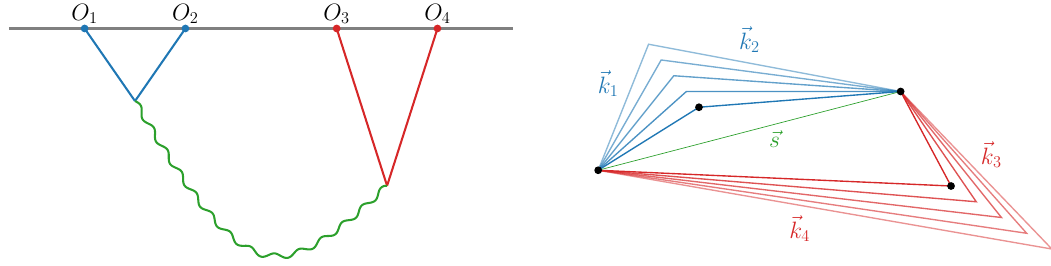
Figure 1: Correlations measured at the end of inflation are created during a period of quasi-de Sitter expansion in the early universe. These correlations capture infor- mation about the production and decay of massive particles during inflation ( left ). For weakly interacting particles, the boundary correlators are constrained by the isometries of the spacetime, which act as conformal transformations on the boundary. These constraints take the form of “conformal Ward identities," which are differential equations that dictate how the strength of the boundary correlations changes when the external momenta are varied ( right ). This momentum dependence encodes fea- tures of the inflationary time